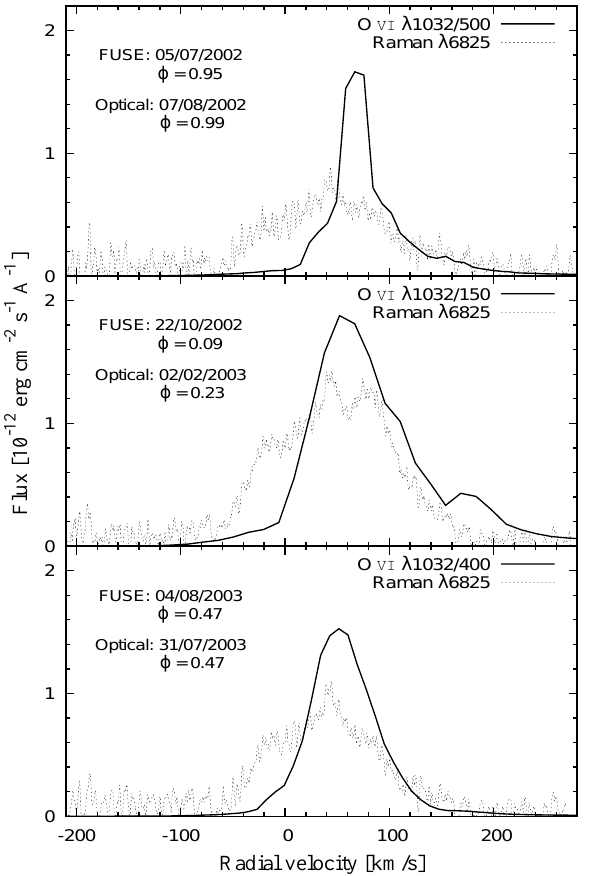
Figure 4: Comparison of the OVI λ 1032˚A line profiles with their Raman scattered counterparts along the out- burst in symbiotic star Z And (adopted from Skopal et al., 2006).